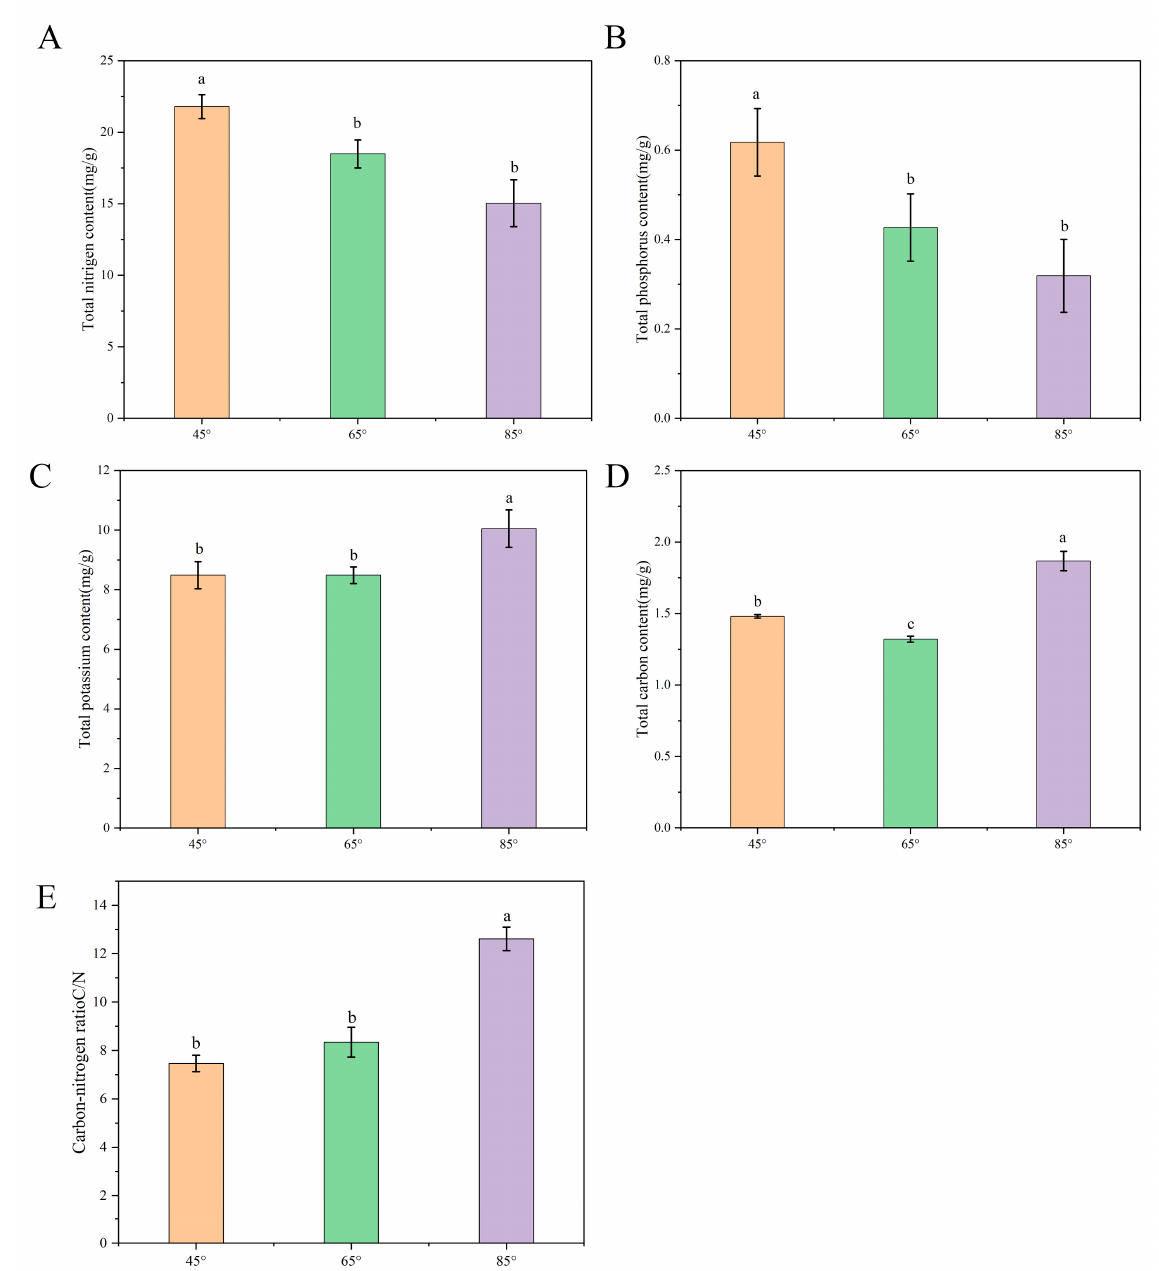
Figure 1. Effects of different main branch base angles on flower bud quality in peach. ( A ) Total nitrogen content; ( B ) total phosphorus content; ( C ) total potassium content; ( D ) total carbon content; ( E ) carbon–nitrogen ratio. Different small letter superscripts mean significant difference ( p < 0.05). Fish-eye photographs of the canopy at different branch opening angles were taken at the end of August when the canopy was in its final stage of formation. This set of pictures can more visually represent the difference in the visible sky ratio DIFN at different branch opening angles. It is clear from the figure that for ‘Lu Hong 618’, the density of the inner branches and leaves was higher when the main branch opening angle was 65 ◦ . The ratio of the visible sky at the bottom of the canopy of 65 ◦ was lower than that recorded for 45 ◦ and 85 ◦ , and the ventilation and light penetration conditions were poor (Figure